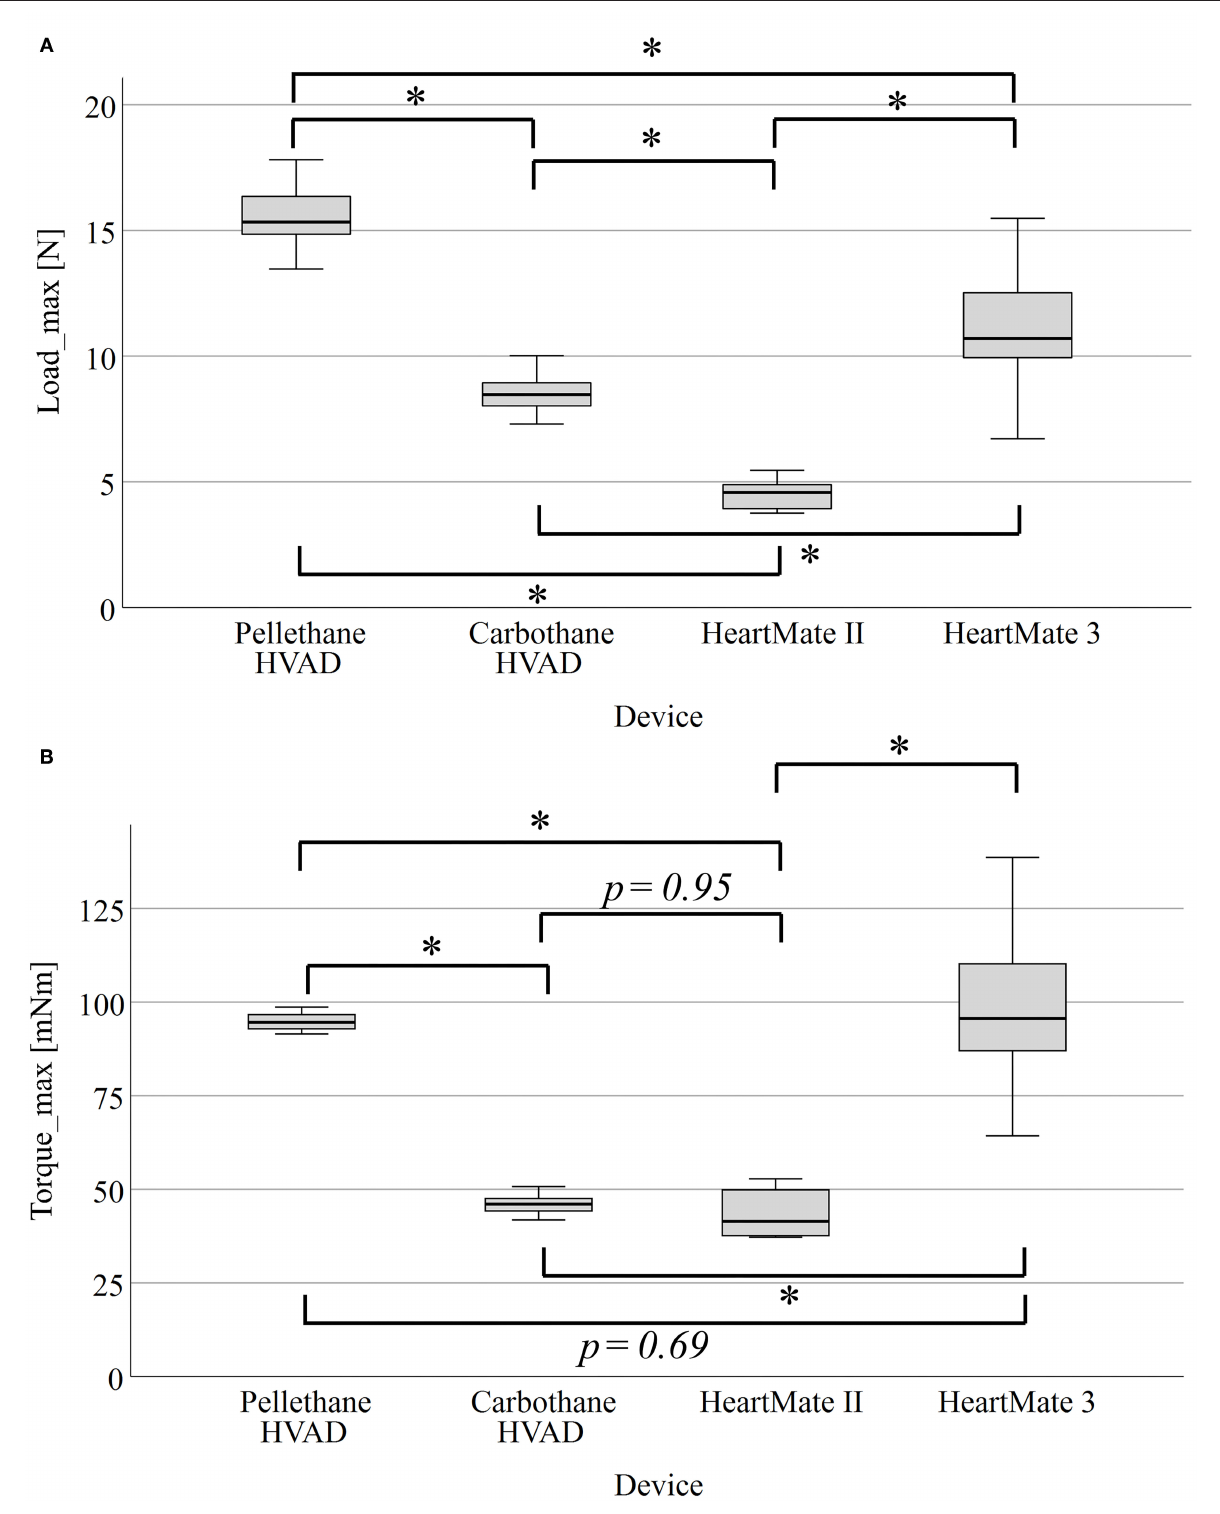
FIGURE 4 | Boxplots of Load max of the three-point bending test of four different driveline types (A) and Torque max of the torsion tests (B) . * p < 0.001. Load max , maximal bending force; Torque max , maximal torque.